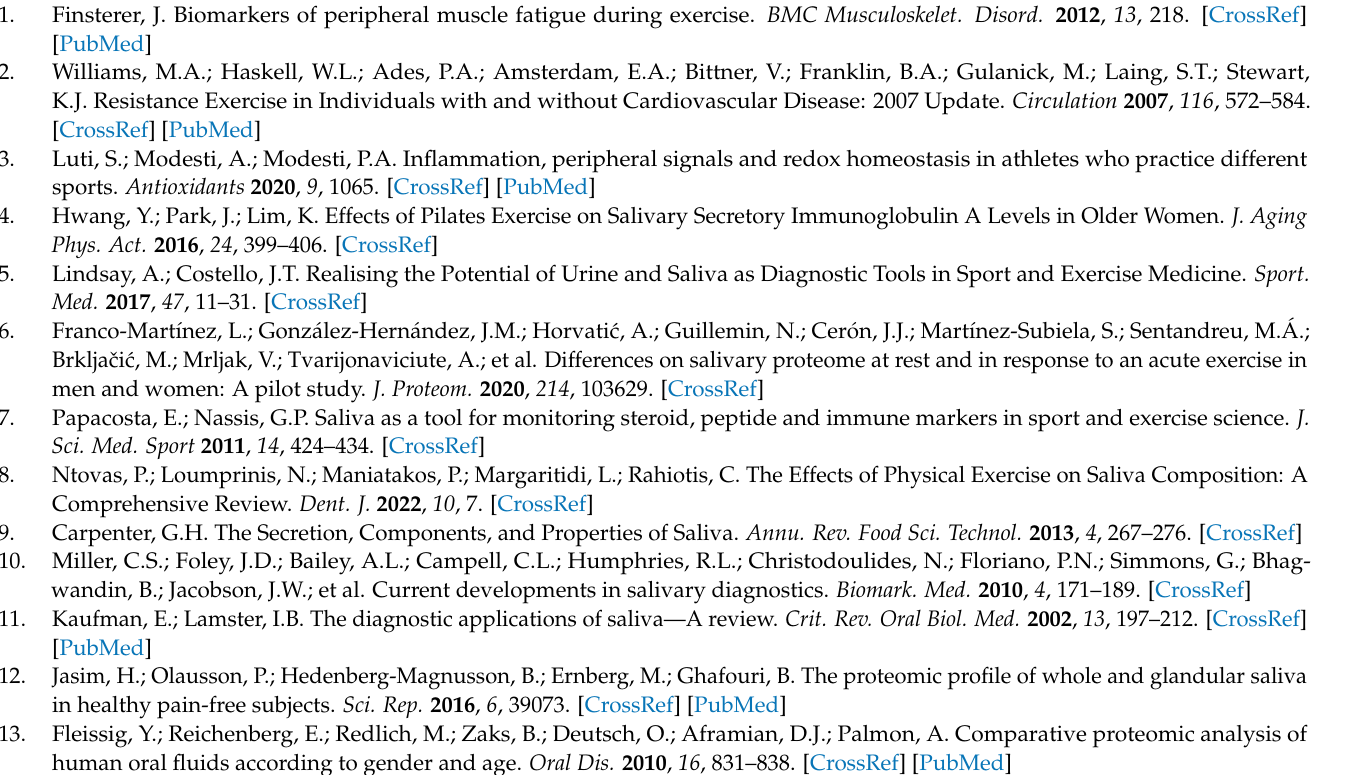
Table S2: List of Metabolites identified in saliva samples of the subject utilized in this study by